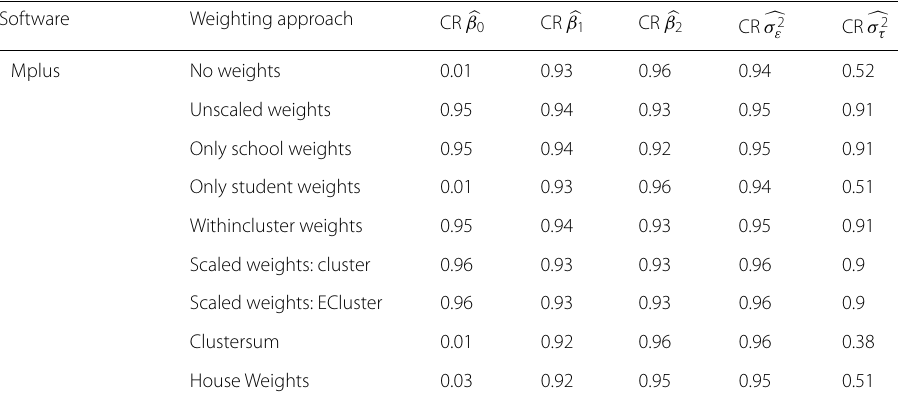
The CR represents the compliance rate of the estimators within its 95% confidence interval of three hierarchical models. Model 1 is declared as y ij = β 0 + τ i + ε ij , Model 2 as y ij = β 0 + β 1 ∗ x ij + τ i + ε ij and Model 3